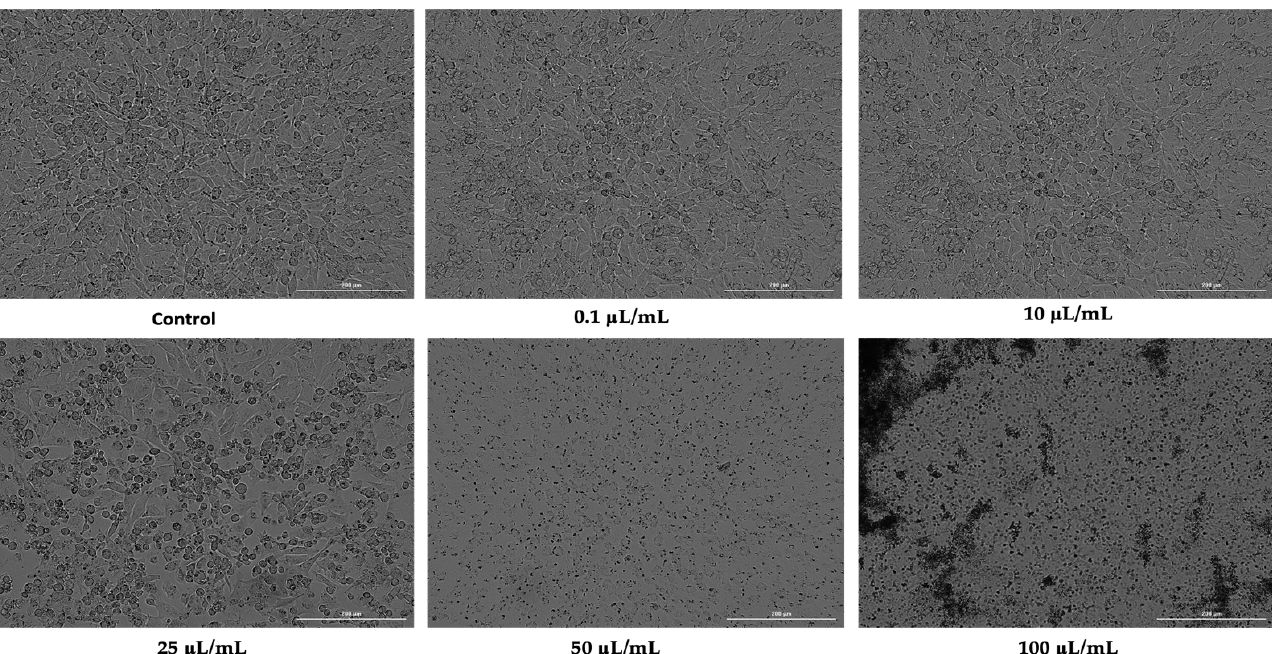
Figure 2. Morphology and confluence of keratinocytes (HaCaT) following 24 h treatment with nicotine at 0.1, 10, 25, 50, and 100 µ L/mL. The scale bars indicate 200 µ m.